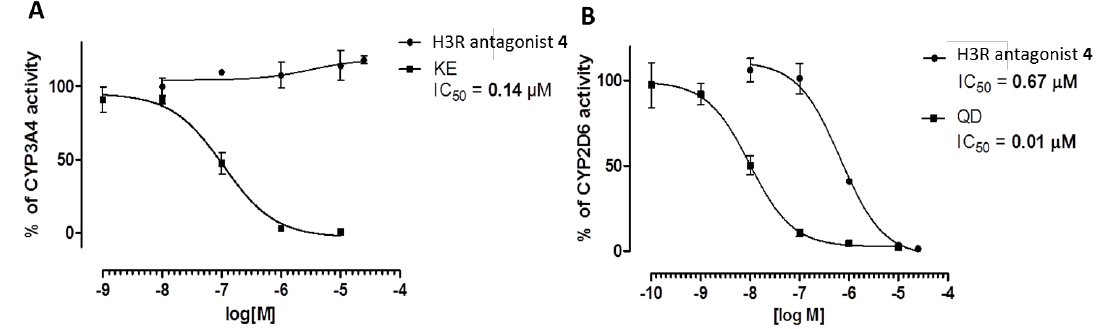
Figure 7. Effect of H3R antagonist 4 on CYP3A4 and CYP2D6 activity. ( A ) Effects of ketoconazole (KE) and H3R antagonist 4 on CYP3A4 activity. ( B ) Effect of quinidine (QD) and H3R antagonist 4 on CYP2D6 activity.